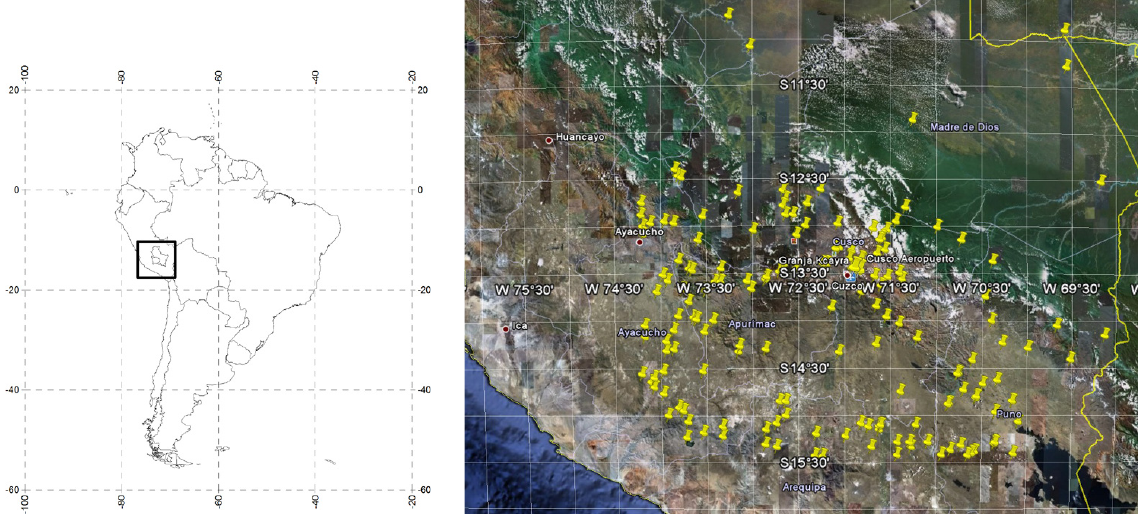
Figure 1. Region Cusco-Apurimac in the Peruvian Central Andes and the respective available climate stations. The plots, as shown, are provided in the PACC data